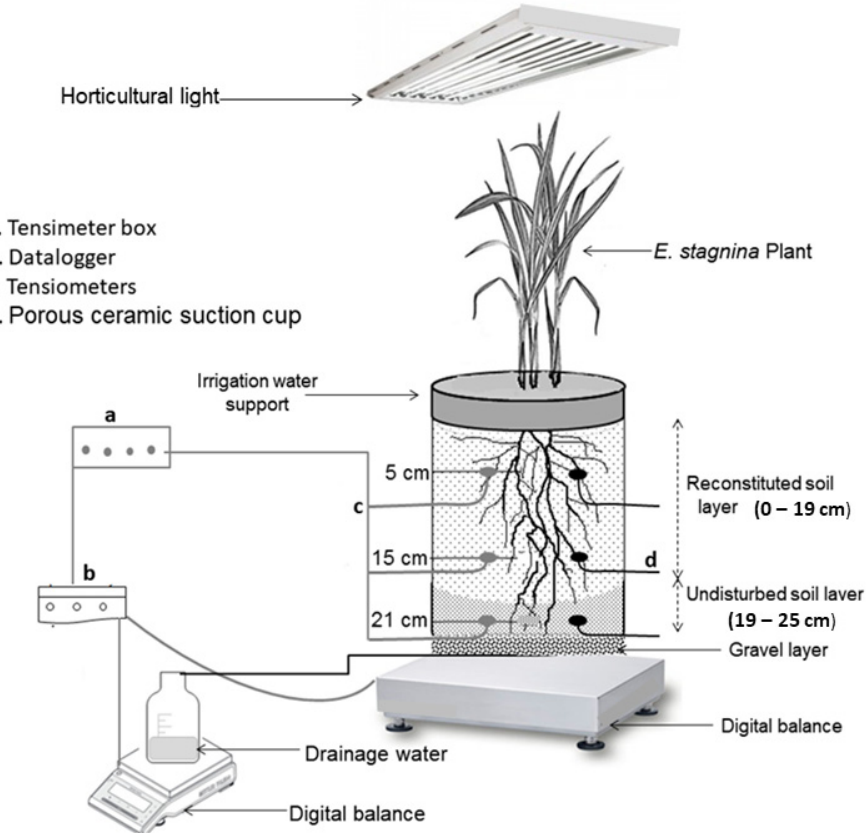
Figure 1. Design of Echinochloa stagnina growth experiment on reconstituted saline Vertisols.